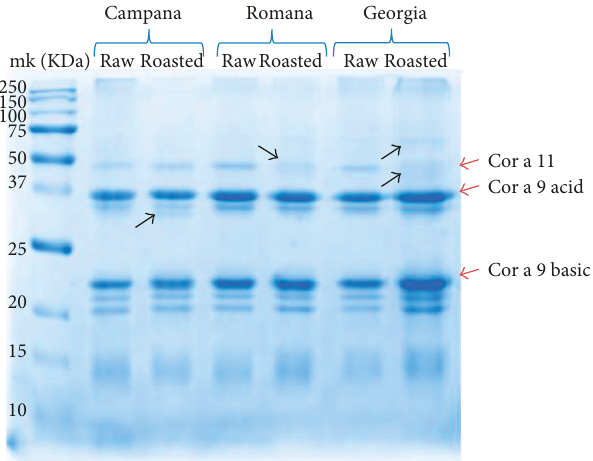
Figure 4: Typical electrophoretic profiles of raw and roasted samples of different hazelnut varieties obtained by SDS-PAGE electrophoresis on 15% polyacrylamide gel. The black arrows show the differences in protein profile induced by the roasting process for each